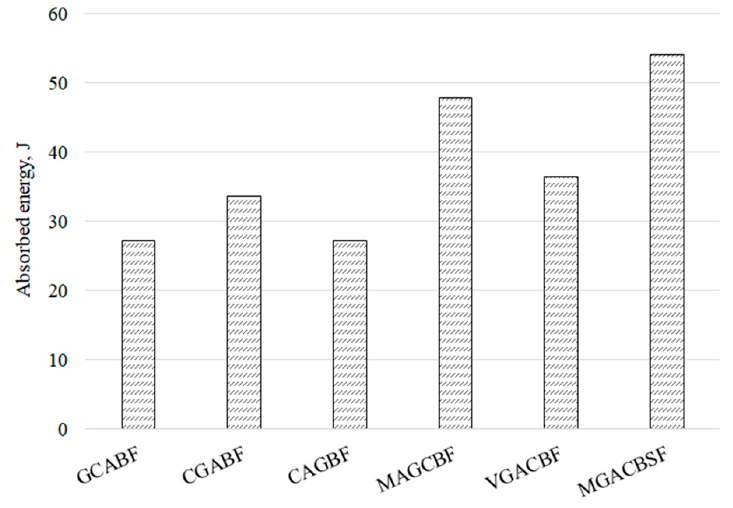
Figure 4. Absorbed energy of